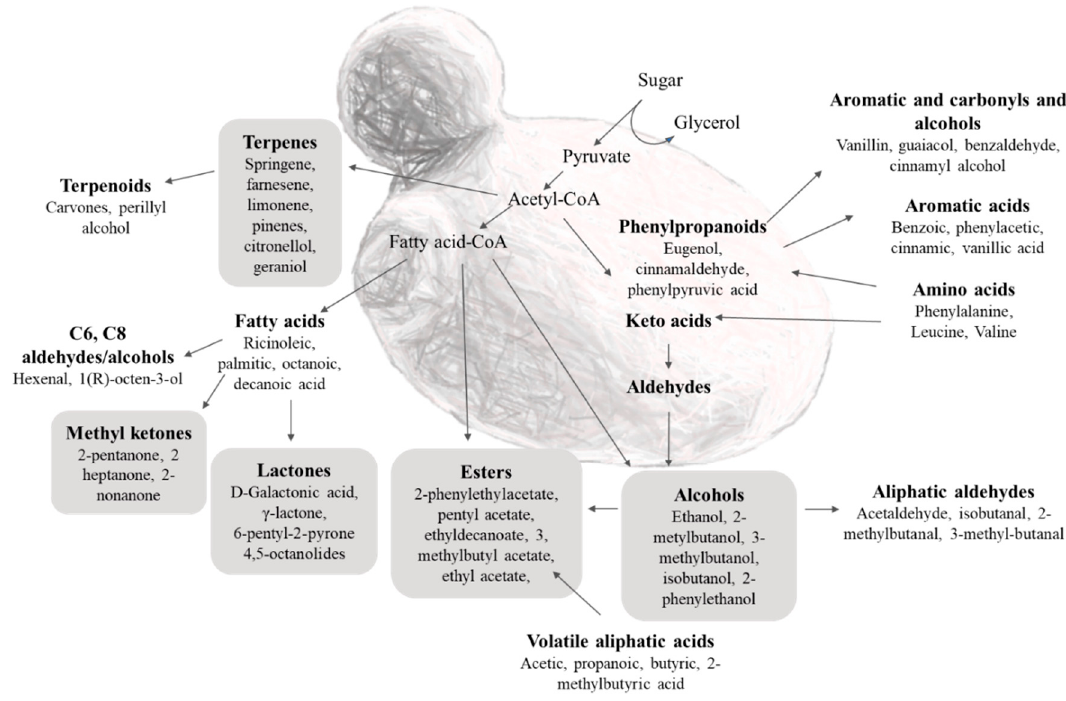
Figure 2. Main metabolic pathways in K. marxianus . Modified from Djordjevi ć et al. [23], and Schrader [24].